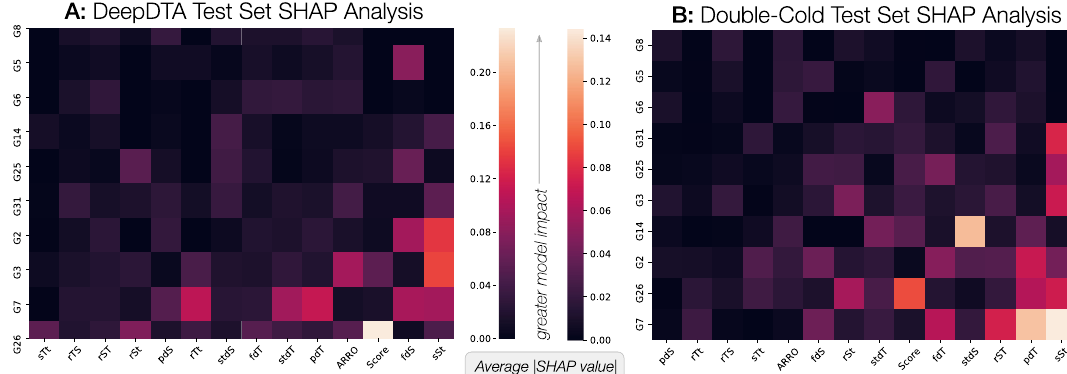
Figure 8. Shapeley additive features analysis. The x-axis is sorted left-to-right in increasing magnitude of SHAP value summed over the column while the y-axis is sorted top-down in increasing magnitude of SHAP value summed over the row. Emanating out from the bottom-right are the models and features with increasingly lesser impact on the model decision. Only the top-10 models contributing to the MUSDTI model are depicted along all 14 RP